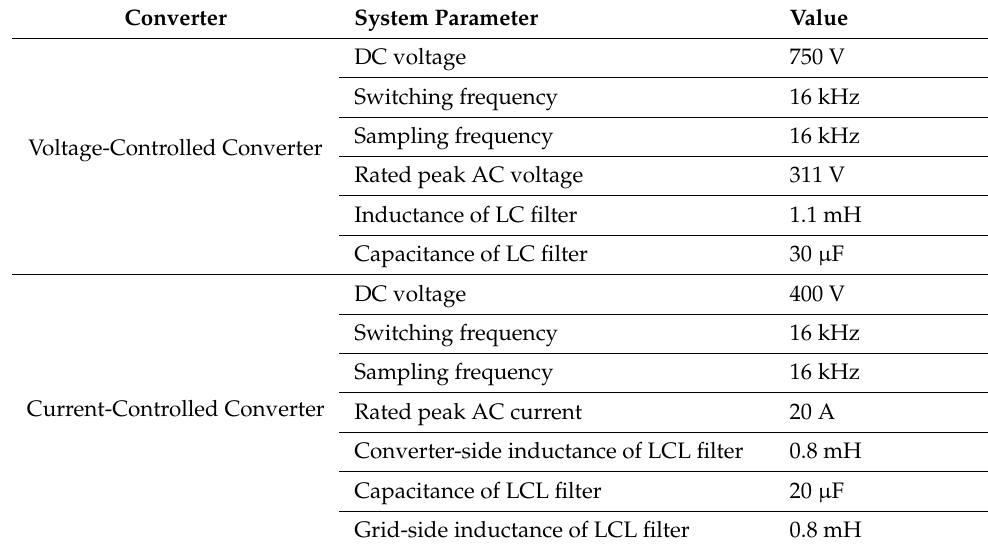
Table 2. Parameters of the dual-loop voltage control scheme.